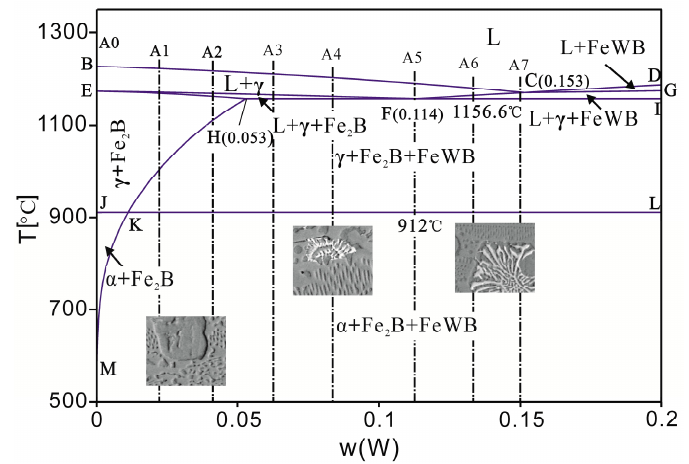
Figure 8. The calculated vertical section of the Fe-B-W ternary system with boron fixed at 3.5 wt % compared with the microstructures of typical alloys.